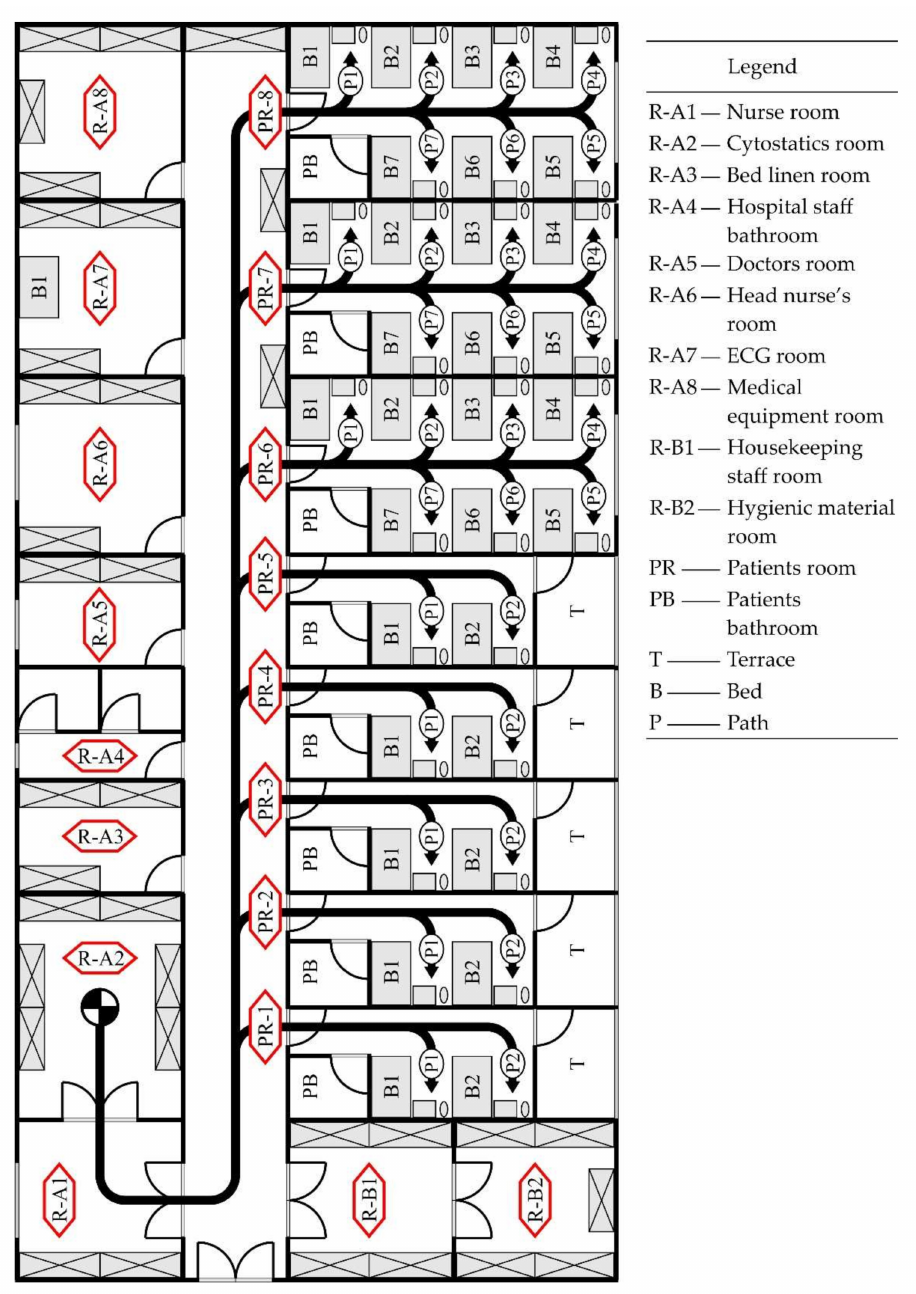
Figure 2. An example of an oncology department: room for nurses (R-A1), room for cytostatics preparation and other medical supplies (R-A2), room for clean linen (R-A3), bathroom for hospital staff (R-A4), room for doctors (R-A5), room for head nurse (R-A6), room for ECG and other minor diagnostics (R-A7), room for medical equipment including mobile and stationary devices and instruments (R-A8), room for housekeeping staff (R-B1), room with material for hospital cleaning and disinfection (R-B2), rooms for patients with two beds each in which there are isolated or immobile patients (PR-1, PR-2, PR-3, PR-4, PR-5), and rooms for patients with seven beds each in which there are mobile patients (PR-6, PR-7,